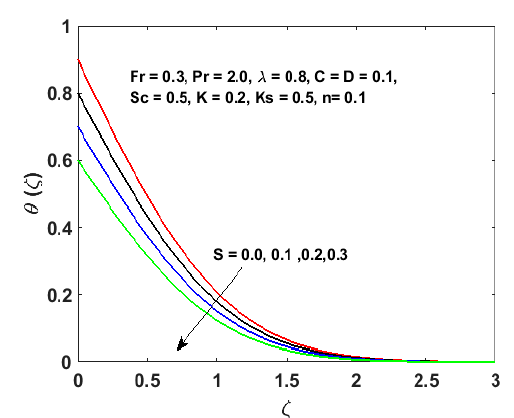
Appl. Sci. 2018 , 8 , x FOR PEER REVIEW